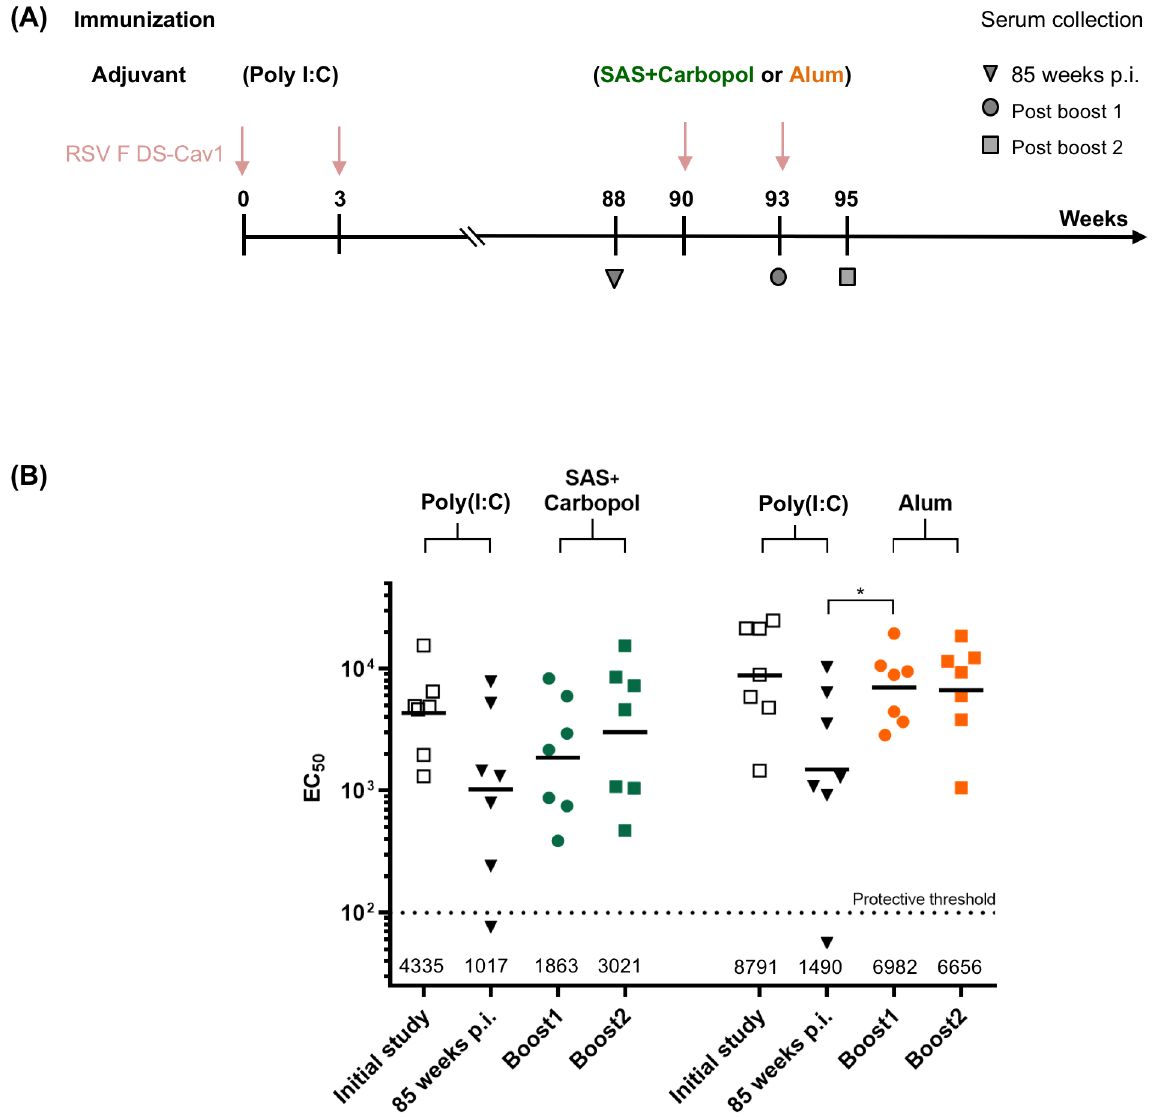
Fig 4. Adjuvanted DS-Cav1can augment RSV-neutralization titers in elderly mice. (A) Pre-immunized elderly mice (DS-Cav1 adjuvanted with Poly (I:C), ~85 weeks wait) were administered DS-Cav1 formulated with Alum or SAS + Carbopol and the immune responsefor all mice assessed. (B) Neutralization titers for each group of seven elderly mice are shown. Scatter plots show the geometric mean (numericalvalue below), the palivizumabprotective thresholdis indicatedby a dotted line [10]. p values were determined by two-tailedWilcoxon matched-pairs signedrank test, p = > 0.05 (ns); p < 0.05 ( * ). Associatedraw data is reportedin S4 Table.